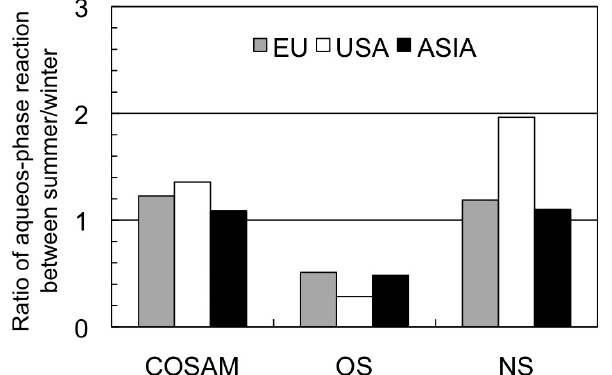
Fig. 9. Ratios of SO 2 aqueous-phase oxidation flux in summer to that in winter over three industrial regions using the COSAM exer- cises, OS and NS,